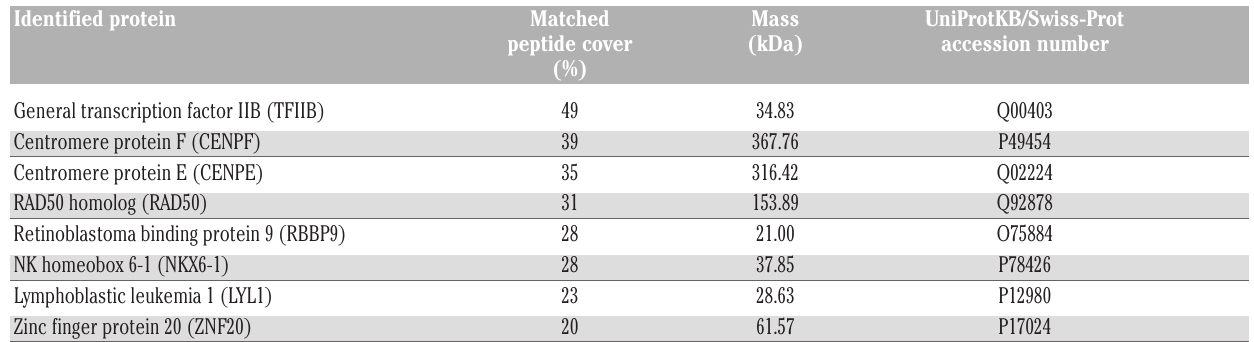
Figure 6. TLX1 interacts with TFIIB. (A) Isolation of TLX1-associated pro- teins. Nuclear extracts from ALL-SIL leukemic T cells were immunoprecip- itated using TLX1-specific antibody (Ab), or no antibody (No Ab) as neg- ative control. Coprecipitated proteins were resolved by SDS-PAGE and sil- ver stained. (B) GST pulldown assay. GST, GST-TLX1 and GST-TLX1 Δ H3 immobilized on glutathione- Sepharose beads were incubated with in vitro-translated, 35 S-labeled TLX1 as positive control, and TFIIB. Bound proteins were washed, eluted, resolved by 12% SDS-PAGE and detected by autoradiography: 50% of the labeled input proteins TLX1 and TFIIB are shown on the